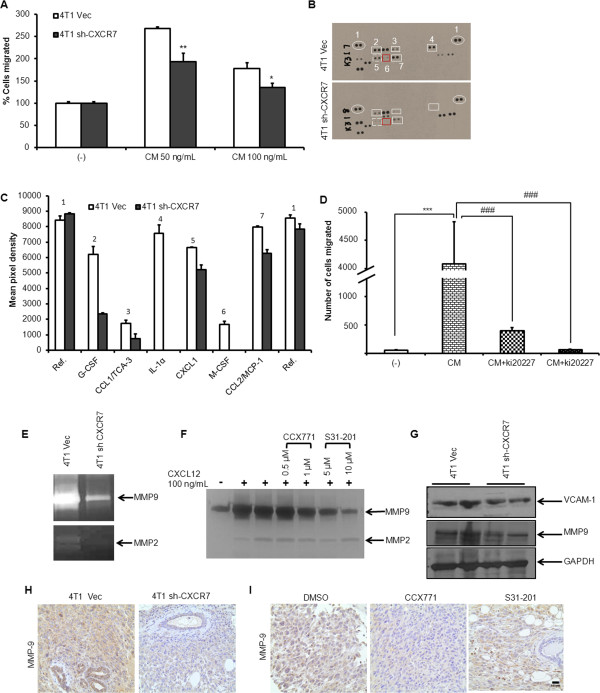
CXCR7 regulates M-CSF, MMPs, and VCAM-1 expression. (A) Murine macrophages (RAW 264.7) were serum starved for 4 hours and plated on the top chamber of 8-μm-pore polycarbonate membrane filters and SFM containing 4T1 or 4T1 sh-CXCR7 CM (50 to 100 μg/ml) was placed in the lower chamber. After 12 hours of incubation, cells that migrated across the filter toward SFM with or without CM (50 to 100 μg/ml) were fixed, stained, and counted by using bright-field microscopy in five random fields. (B) Conditioned media (CM) obtained from Vector or CXCR7-downregulated cells were subjected to cytokine profiling. (C) The array data were quantitated by ImageJ to generate a protein profile (histogram) (D) Murine macrophages (RAW 264.7) were serum starved for 4 hours and treated with 50 and 100 μM ki20227 (MCSF-R inhibitor) and then plated on the top chamber of 8-μm-pore polycarbonate membrane filters. SFM, in the absence or presence of 4T1 CM (100 μg/ml), was placed in the lower chamber. After 12 hours of incubation, cells that migrated were fixed, stained, and counted by using bright-field microscopy in five random fields. (E) CM obtained from vector or CXCR7-downregulated cells was subjected to gelatin zymography for MMPs activity. (F) CM obtained from 4T1.2 cells treated with CXCR7-specific (CCX771) at 0.5 and 1 μM concentration or STAT3-specific inhibitors (S31-201) at 5 and 10 μM concentration in the presence and absence of CXCL12 (100 ng/ml) were subjected to gelatin zymography. (G) 4T1 and 4T1 shCXCR7 cell line-derived tumors were lysed and analyzed for VCAM-1, MMP-9, and GAPDH expression by Immunoblotting. The 4T1 Vec, 4T1 sh-CXCR7 (H), and 4T1.2 (I) cell line-derived tumors from CCX771 or S31-201 treated or untreated groups were subjected to immunohistochemical staining for MMP-9 expression (40×). Data represent the mean ± SD per experimental group. Scale bars, 0.03 mm. **P < 0.01, ***P < 0.001 versus none and ###P < 0.01 versus control.